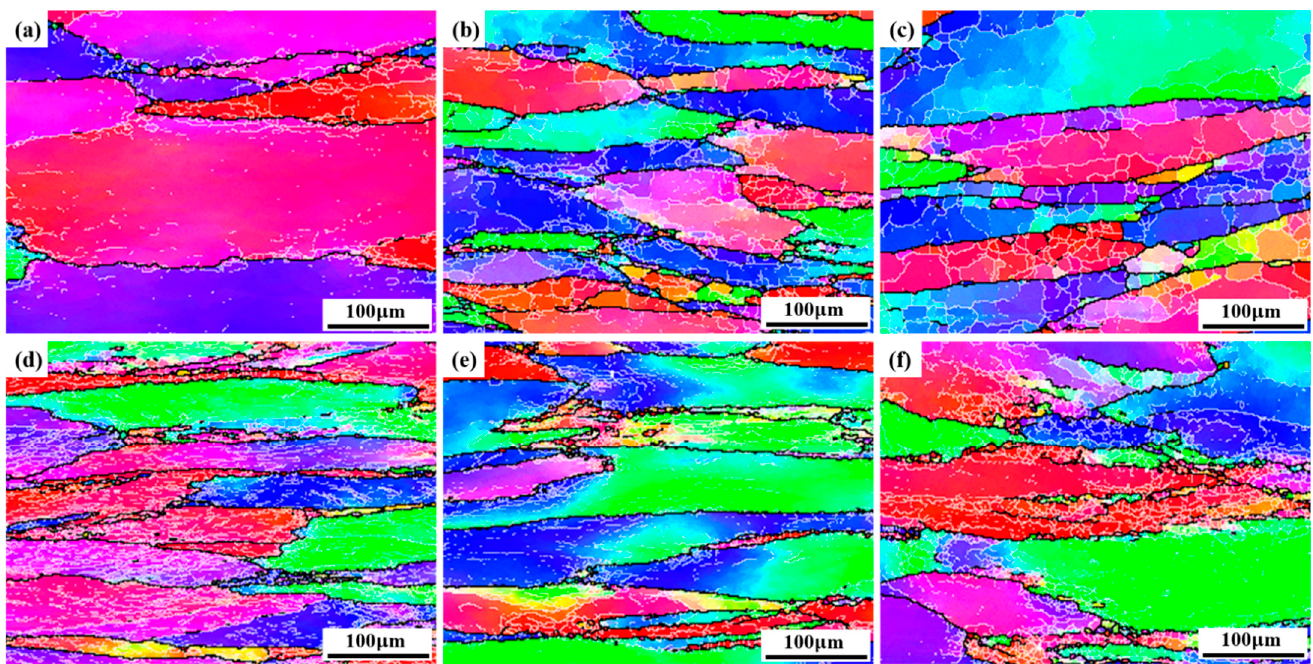
Figure 8. IPF maps of HG AA2195 Al-Li alloy under different thermal deformation conditions: ( a ) 360 °C, 0.01 s − 1 ; ( b ) 420 °C, 0.01 s − 1 ; ( c ) 480 °C, 0.01 s − 1 ; ( d ) 360 °C, 10 s − 1 ; ( e ) 420 °C, 10 s − 1 ; ( f ) 480 °C, 10 s − 1 .